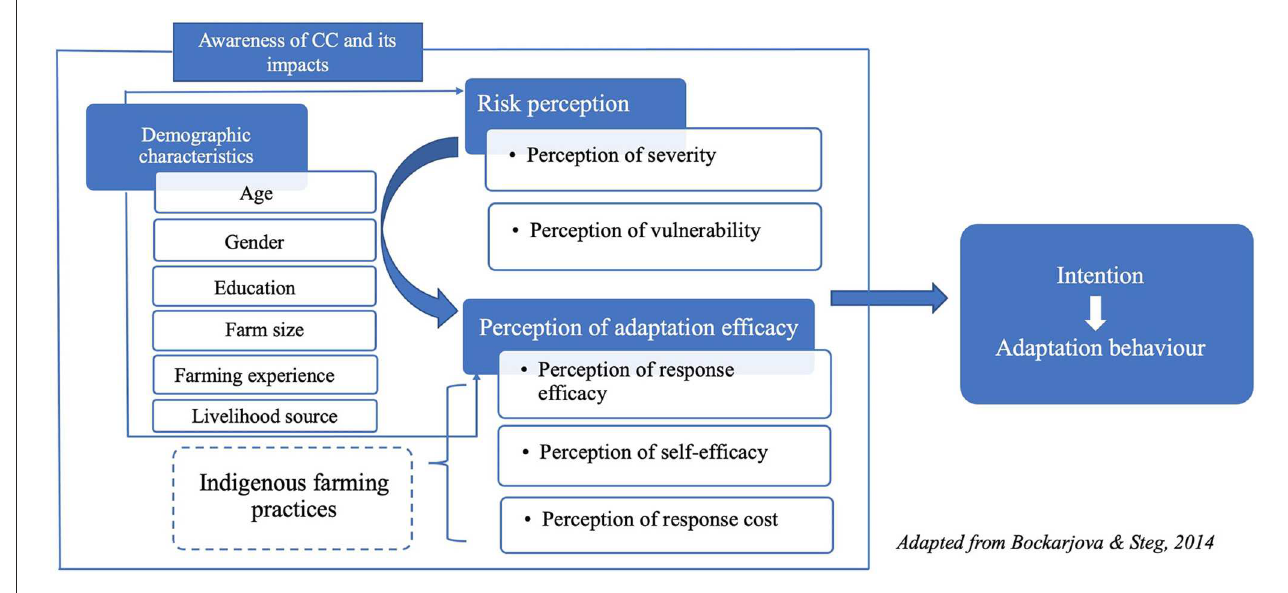
FIGURE1 Analytical framework for the study (Adapted from Bockarjova and Steg, 2014).